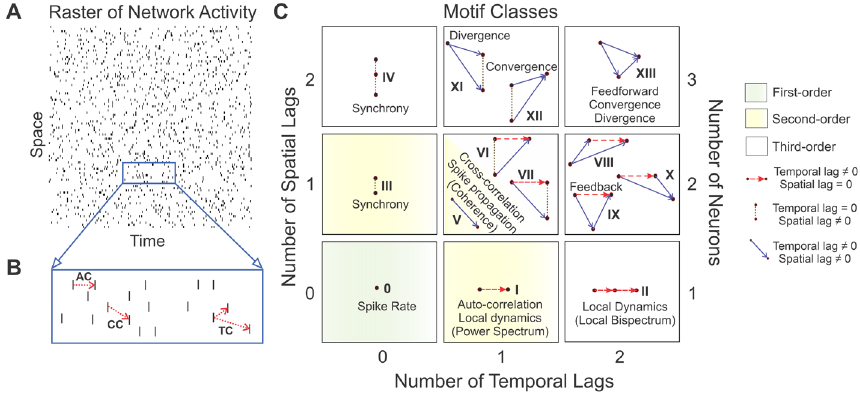
Figure 1. Application of the fourteen motif classes to spike rasters. For a given raster (Panel A ), second-order correlations can relate activity within a neuron (auto-correlation, AC; Panel B ) or between neurons (cross- correlation, CC; Panel B ). Triple correlation (TC; Panel B ) relates three bins, separated by up to two temporal and two spatial lags. Three particular spike bins constitute a triplet motif (e.g. as shown in Panel B ). We classify these motifs into fourteen motif classes by the motif’s spike sequence (Panel C ; see Online Methods for a complete derivation). Dot: a single spike bin. Horizontal red dashed arrow: intraneuronal spike bins, i.e. space lag = 0 , e.g. I and II. Vertical stippled line: synchronous spike bins, i.e. time lag = 0 , e.g. III and IV. Solid blue arrow: interneuronal spike bins (e.g. V). These 14 motif classes can also embody well-known neuronal processing properties (such as synchrony, feedback, convergence, divergence, and feedforward) in both the time (listed adjacent to the motif class) and frequency domains (listed within parentheses). First- (0) and second- order (I, III, and V) motif classes are highlighted in green and yellow, respectively. The second-order motif classes I, III, and V are constituent motif classes that comprise the third-order motifs. The remaining ones are third-order motif